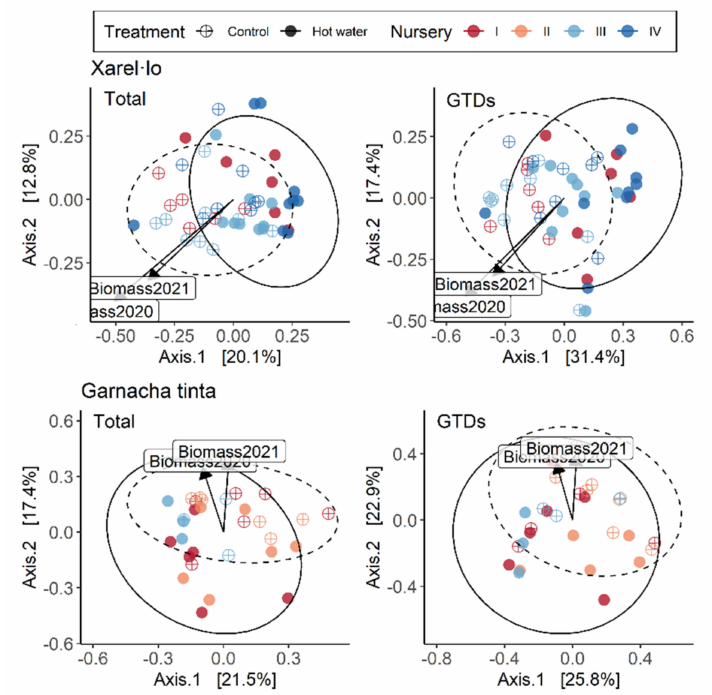
Figure 6. PCoA ordinations calculated with a Bray-distance matrix showing the contribution of varieties Xarel · lo ( top ) and Garnacha Tinta ( bottom ) to variation in the total fungal community ( left ) and the GTD-related fungal community ( right ) in plants originating from each nursery and for each treatment in graft unions. The R 2 and p -values shown are extracted from a PERMANOVA analysis performed with the adonis2 function in